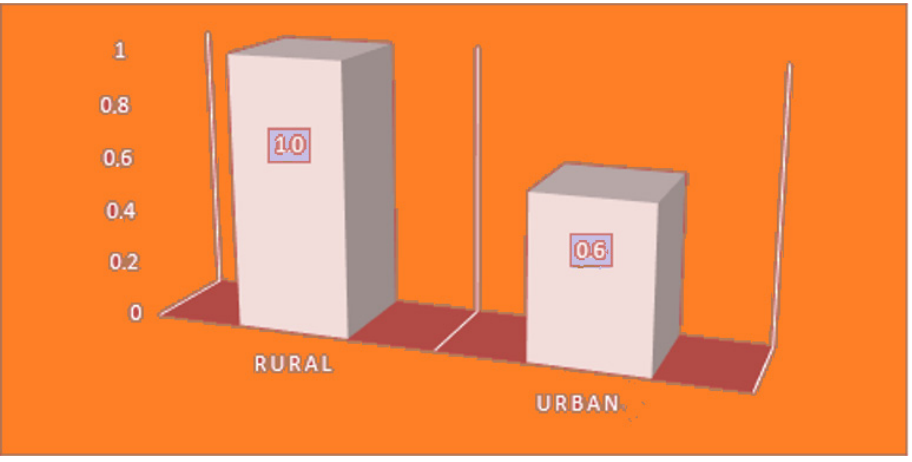
Figure 5. Daily income of the poorest 40%. Source: INE/IBEP.